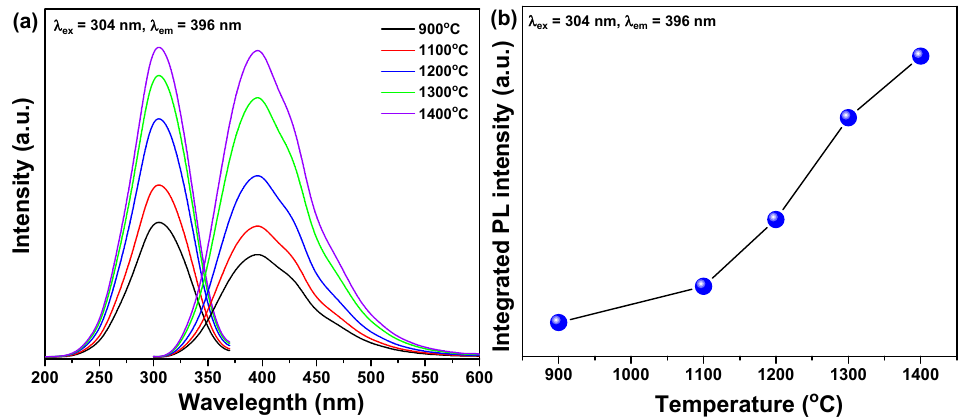
Figure 5. ( a ) Photoluminescence excitation (PLE) and photoluminescence (PL) spectra and ( b ) integrated PL intensity of Ce 3+ -doped h-BN nanophosphors in relation to re-heating temperatures of 900, 1100, 1200, 1300 and 1400 °C.